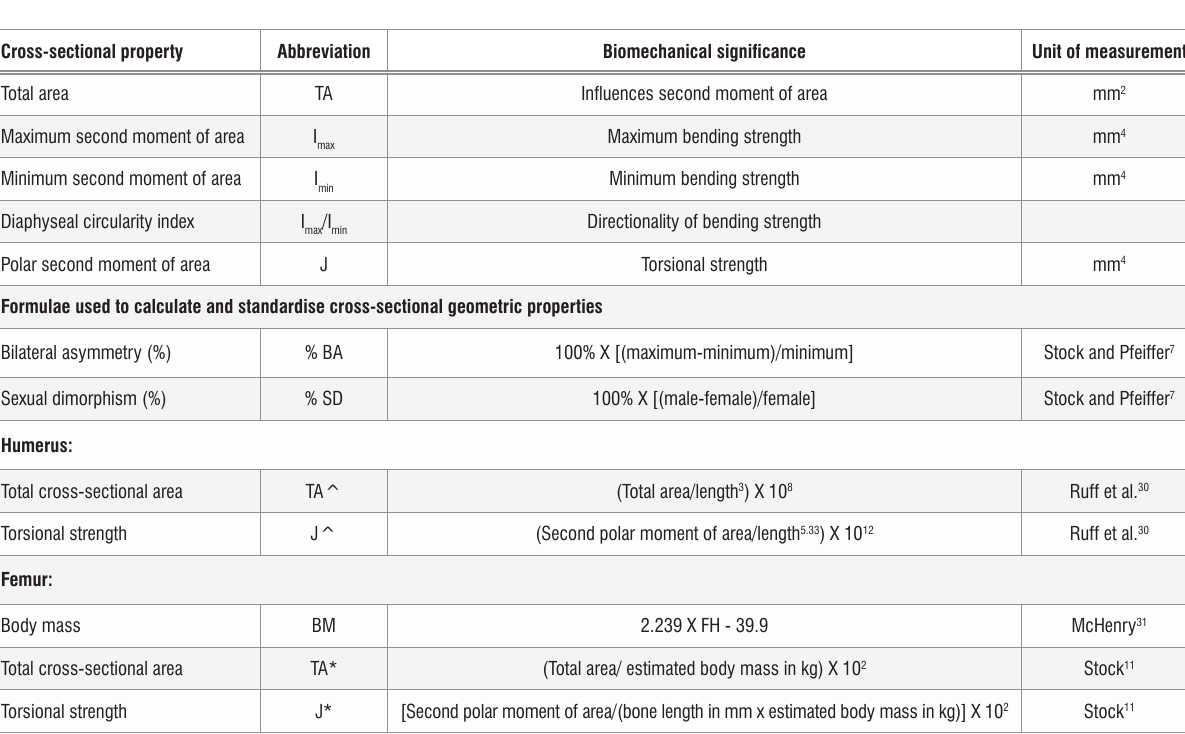
Cross-sectional